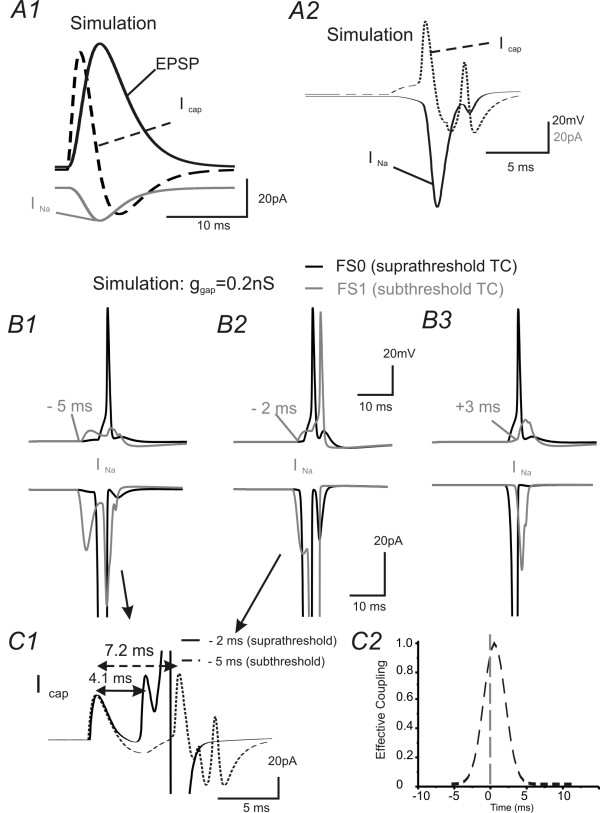
Mechanisms of interaction of transient EPJP and EPSPs. A1) EPSP underlying ICapand INa in soma of a simulated FS cell. The ICap precedes the onset of INa. A2) In a GJ coupled pair, a suprathreshold current induced an AP in a presynaptic FS cell (not shown), and post-junctional responses (not shown). The ICap and INa of the postsynaptic (via GJ coupling) cell was plotted. The two transient ICap precedes the onset of INa . B1-3) A critical time window for TC and EPJP interactions. Two TC inputs arriving at the GJ coupled FS pairs, respectively. A weak, subthreshold TC input arrives at FS1 (gray trace) at different time point in reference to the time of a strong, suprathreshold TC input to FS0 (black trace C1) The ICap of FS1 in B2 and B1 was aligned at the onset of the two TC inputs. Note that the initial ICap transients are the same (because TC input maintains the same). However, the second transient ICap arriving 3 ms earlier (4.1 ms vs. 7.2 ms) and resulted in larger INa (suprathreshold) in FS1 (solid line). C2) The effective coupling (number of spikes/number of TC inputs) between the two transient TC inputs was plotted as a function of interval of the two TC transients in a FS cell with EPJP of 0.2 nS.